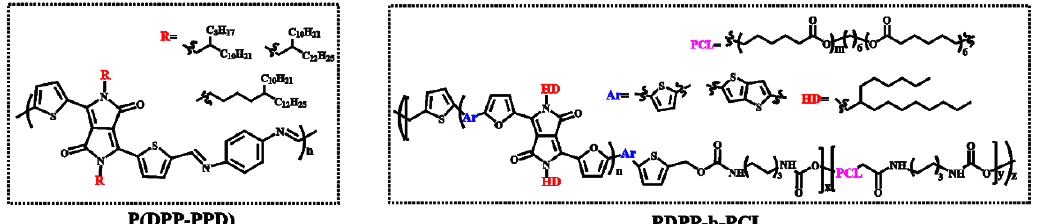
Figure 4. Chemical structure of IEOSs obtained by polycondensation reaction.